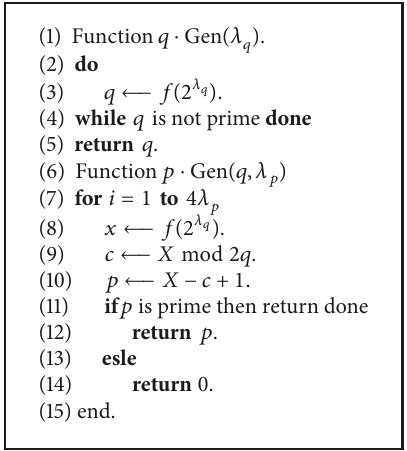
Algorithm 2: Fully homomorphic tag generation